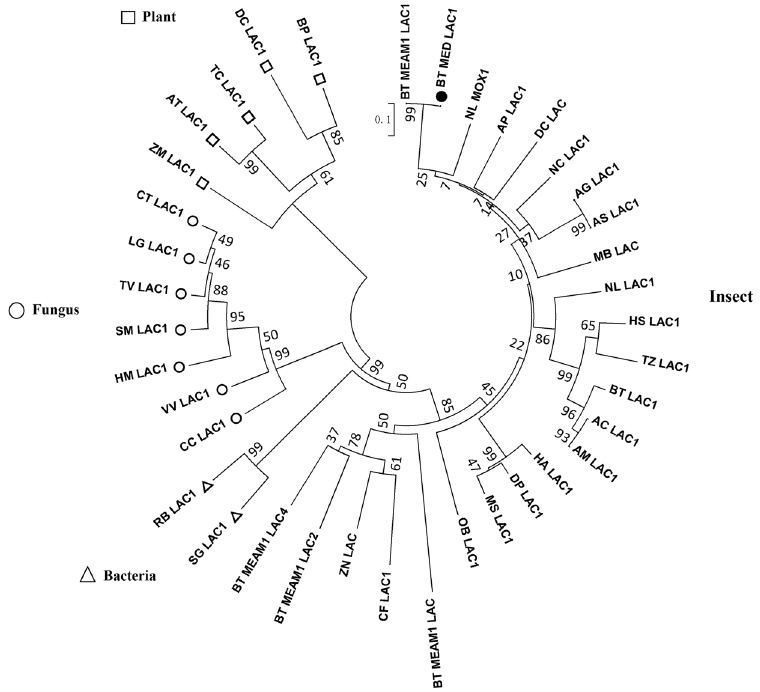
Figure 1. Phylogenetic trees comparing B. tabaci MED LAC1 and the known insect LAC genes. The phylogenetic tree was generated by MEGA 5.05 based on the neighbour-joining method according to amino acid sequences. Bootstrap support values calculated on 1000 replications are shown on the branches. The laccase sequences used to generate the tree are listed in Table